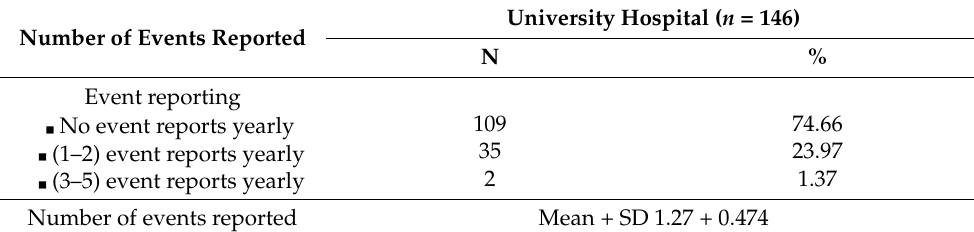
Table 1. Socio-Demographic and Work-Related Characteristics of the Study Subjects.